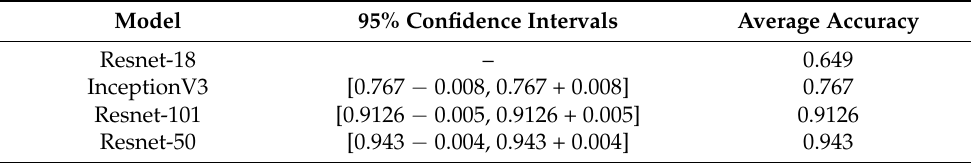
Figure 6. Comparison results of Recall, Precision, F1_score for three models.